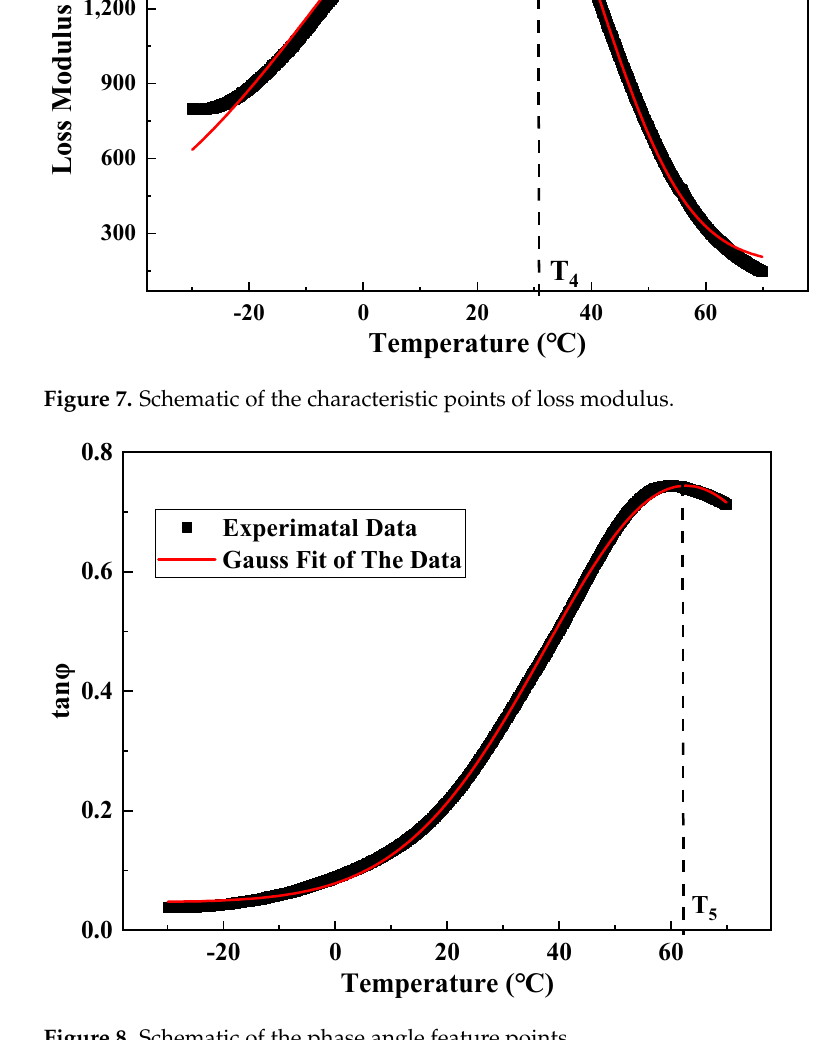
Figure 8. Schematic of the phase angle feature points. Asphalt mixture is a typical viscoelastic material whose pavement properties change with load and temperature. In this study, the core samples of RIOHTrack with different loading cycles were drilled, and the surface layers of three types and six structures were tested by using the test method described in Section 2.2.3. Five characteristic temperatures T 1 –T 5 were obtained by using the above-mentioned data processing and analysis methods. T 2 , T 4 , and T 5 were used to characterize the low, medium, and high temperature properties of the asphalt mixture, respectively. The long-term performance evolution law of the